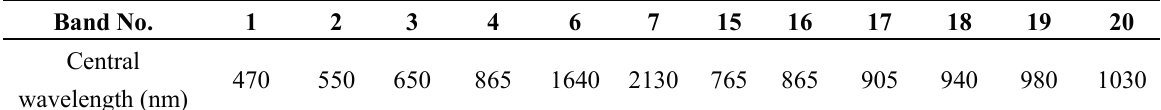
Table 2. Wavelength of MERSI reflective solar bands used in the direct estimation algorithm. Band